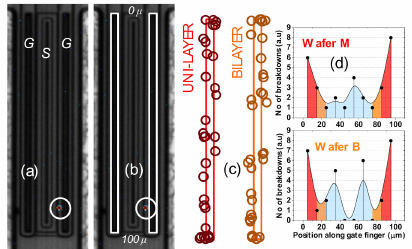
Figure 8. Breakdown spot mapping using V DS step stress with electroluminescence imaging ( a ) example of a device image with an observed breakdown spot; ( b ) outline of the two 100 µ m gate fingers which together represent the map area; ( c ) EL spot locations over both gate fingers superimposed onto the mapping region, for each wafer ( d ) number of breakdown occurrences distributed over 10 equal intervals along the width of the gate